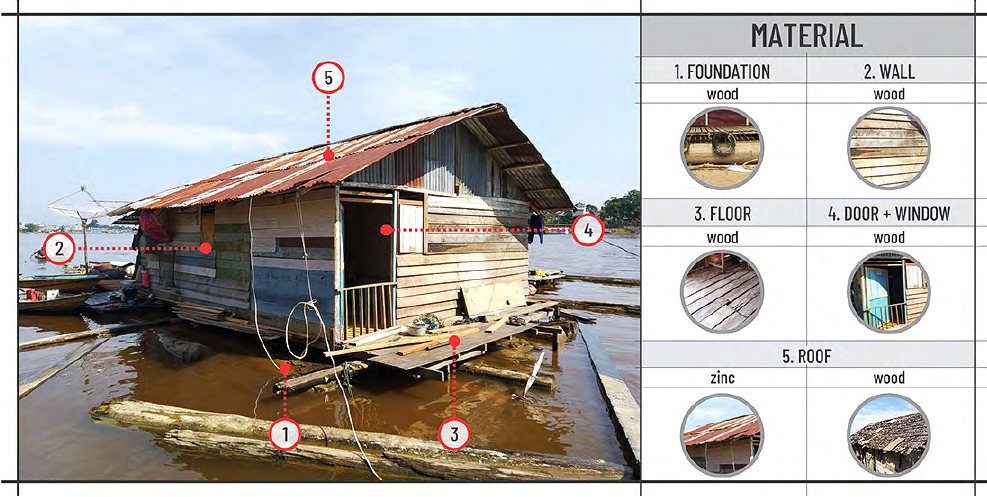
Figure 5. Materials of Rumah